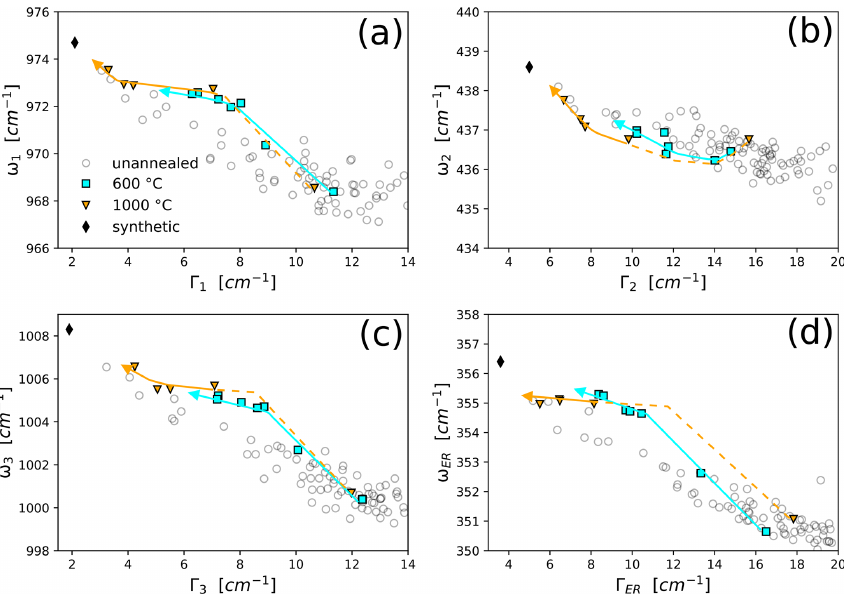
Figure 4. ω – (cid:48) plots of the ν 1 (SiO 4 ) (a) , ν 2 (SiO 4 ) (b) , ν 3 (SiO 4 ) (c) , and ER (d) Raman bands for the isothermal annealing runs of two zircons at 600 and 1000 ◦ C. The initial damage density was ∼ 70 × 10 16 α /g for both zircons. Annealing durations were 10, 30, and 90min, 5h, 1, and 5d for the 600 ◦ C experiment and 10, 30, and 90min, and 1d for the 1000 ◦ C. Gray circles represent the unannealed zircons from which the annealed samples were selected. The arrows are orientation guides for the annealing trajectories. The dashed line represents an expected trajectory for the stage I annealing at 1000 ◦ C, for which the zircon already reached stage II during the first annealing